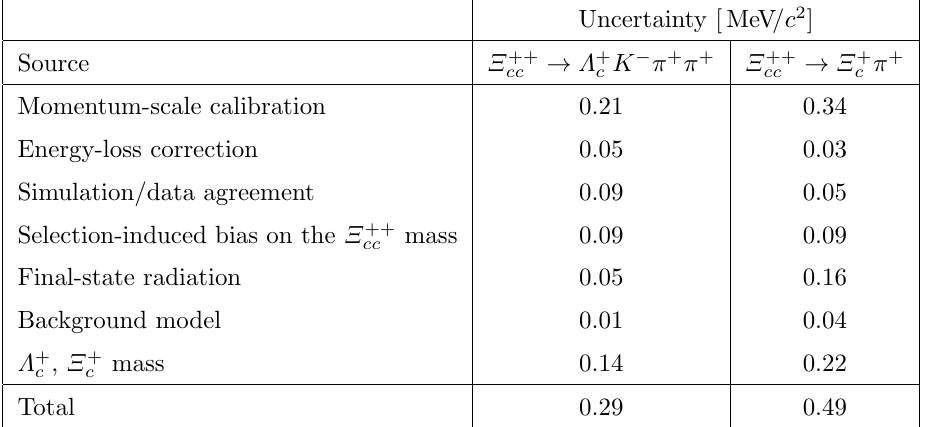
mass measurements using (cid:4) ++ cc